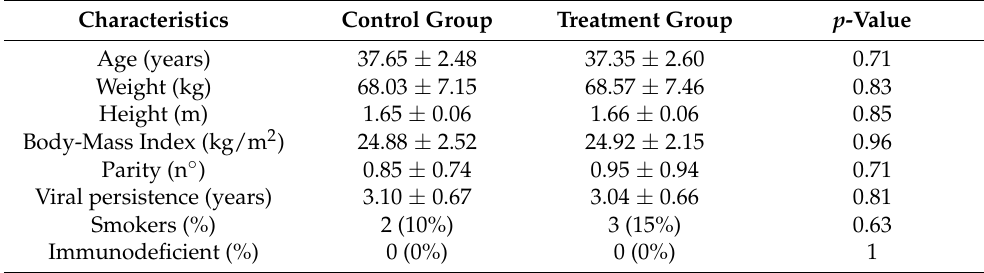
Table 1. Baseline characteristics of patients in the